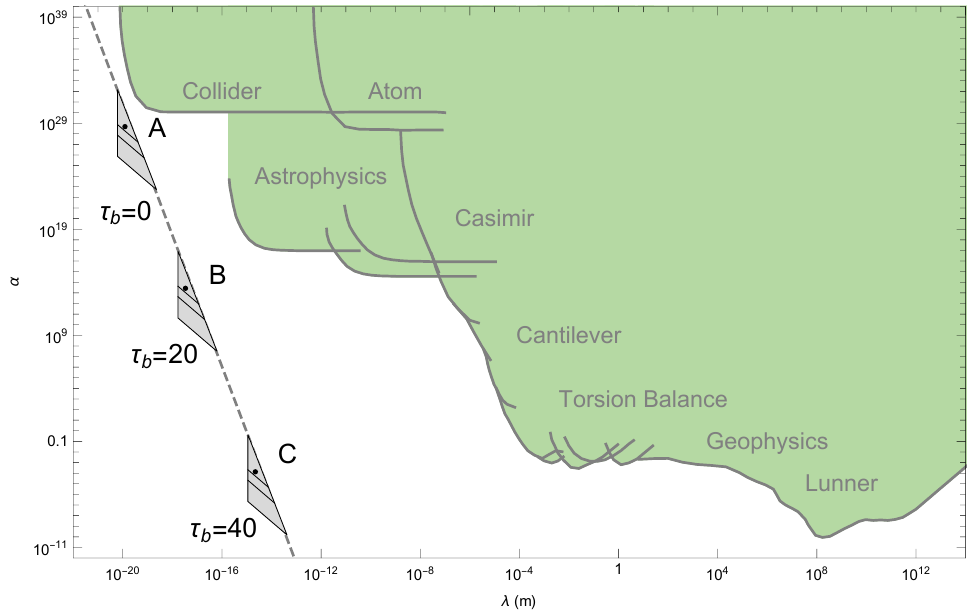
Figure 11 . The shaded triangles correspond to the allowed regions of parameter space for the fully warped limit τ c → T , for different choices of τ b and fixed H = 10 − 15 . All points ( A, B, C ) have g s = 0 . 2 , M = 20 . The upper right bounds on each region follow from (4.37) and g s < 1 , while the left bounds follow from (4.35b) and g s M > 1 . The lower lines in each triangle represent the lower bound on (4.38) with M < 32 , 100 , 1000 (with larger values giving weaker bounds, i.e. lower lines). Figure adapted from [23, 64], with the shaded area indicating the excluded region of parameter space at 95% confidence